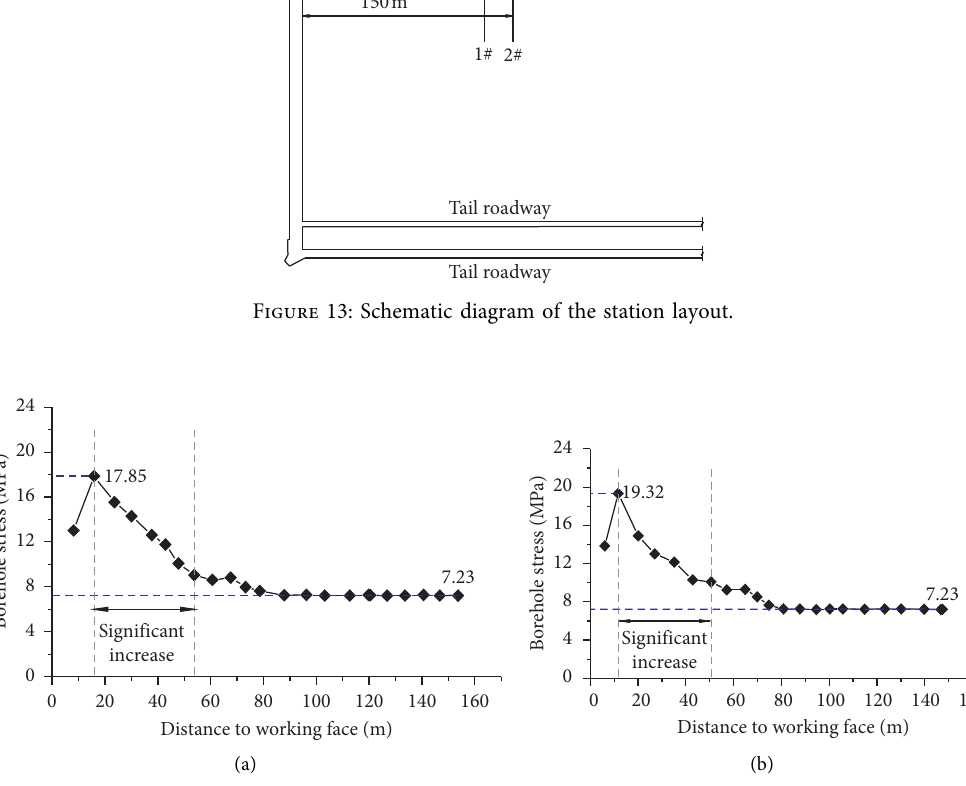
Figure 14: Lead abutment pressure monitoring results. (a) 1# Borehole. (b) 2# Borehole.